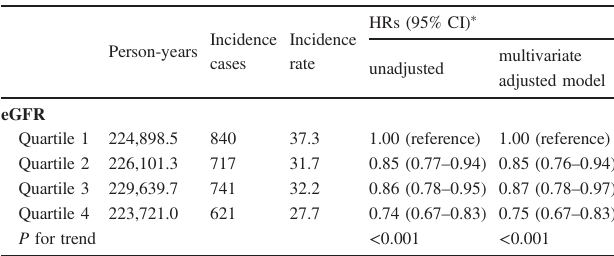
CI, con fi dence interval; eGFR, estimated glomerular fi ltration rate (mL = min = 1.73m 2 ); HR, hazard ratio. Multivariate adjusted model was adjusted for gender, body mass index, systolic blood pressure, fasting glucose, total cholesterol, gamma-glutamyl transferase, smoking amount (pack-years), alcohol intake, and physical activity. Quartile 1: eGFR <71.08, Quartile 2: eGFR 71.08 – 83.10, Quartile 3: eGFR: 83.11 – 95.06, Quartile 4: eGFR